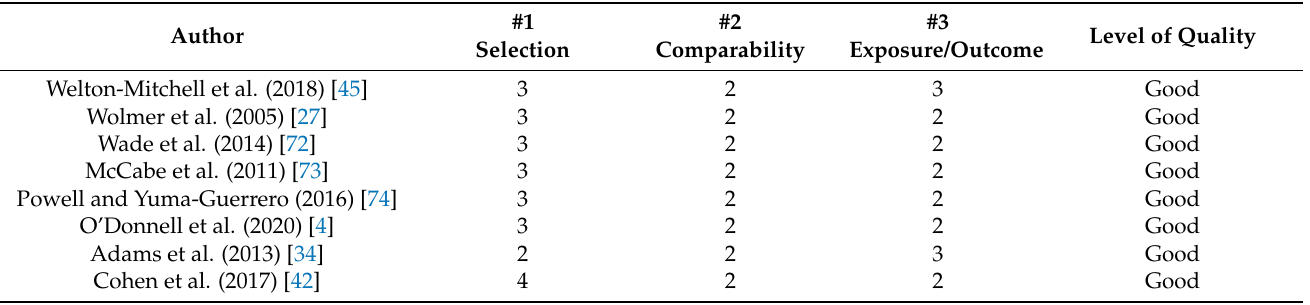
Table 3. Quality Assessment of non-randomised studies using the Newcastle–Ottawa Scale (NOS) assessment tool